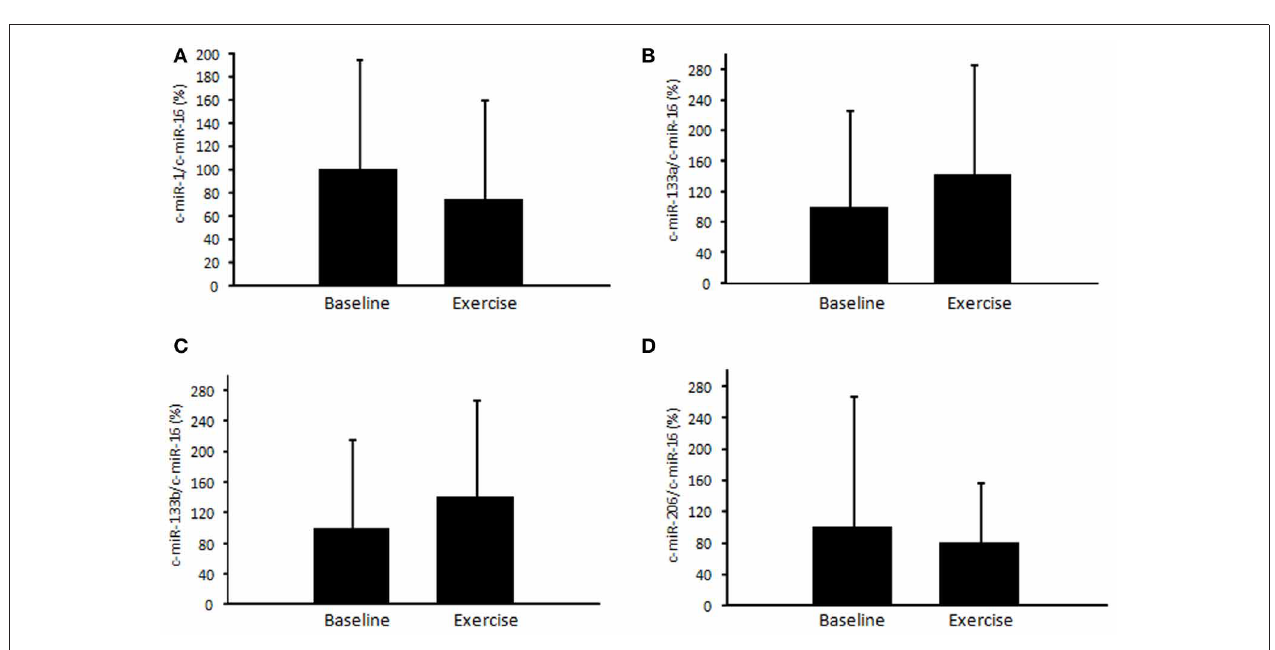
determined. The ratio of the signal for microRNAs to that for miR-16 was calculated for each serum sample. Values represent as the mean ± standard deviation obtained from 11